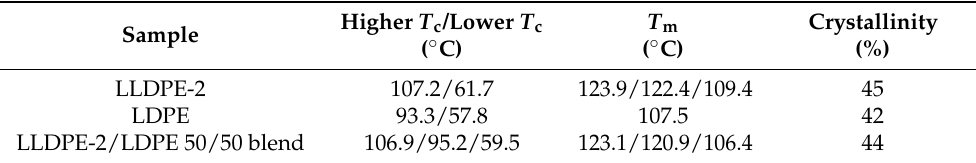
Table 6. DSC data of the LLDPE-2/LDPE 50/50 blend compared with the neat components. Higher T c /Lower T Sample